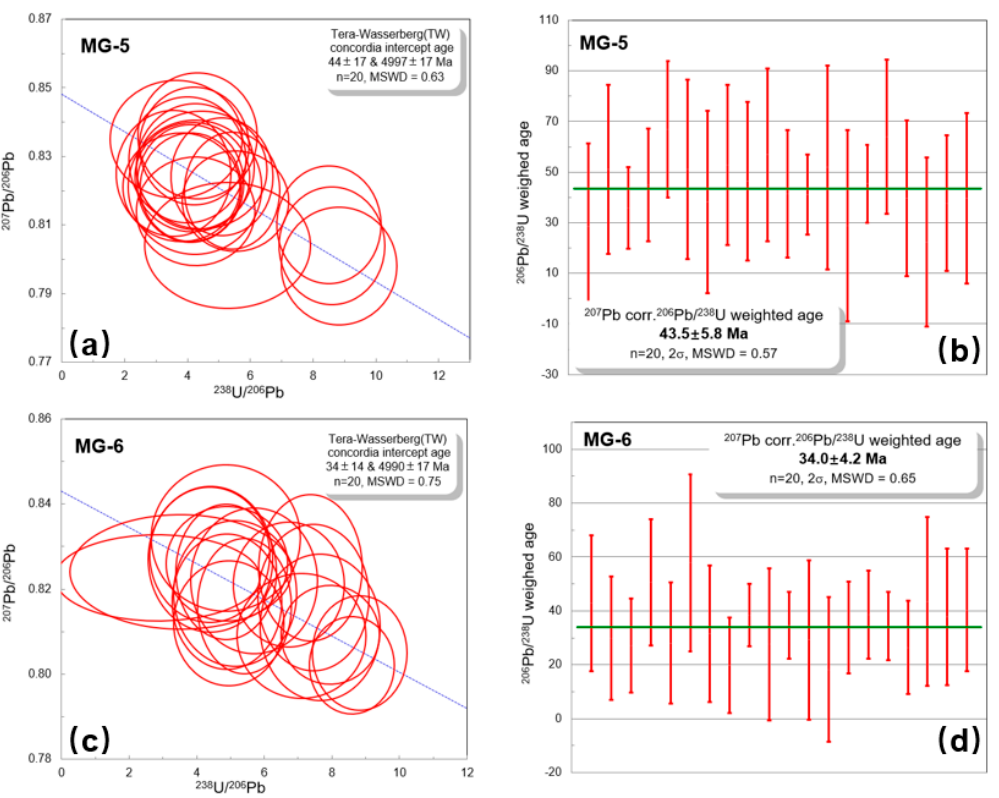
Figure 10. LA-ICP-MS titanite U–Pb TW diagram ( a ) and 206 Pb/ 238 U weighed age for MG-5 ( b ); LA- ICP-MS titanite U–Pb TW diagram ( c ) and 206 Pb/ 238 U weighed age for MG-6 ( d ).